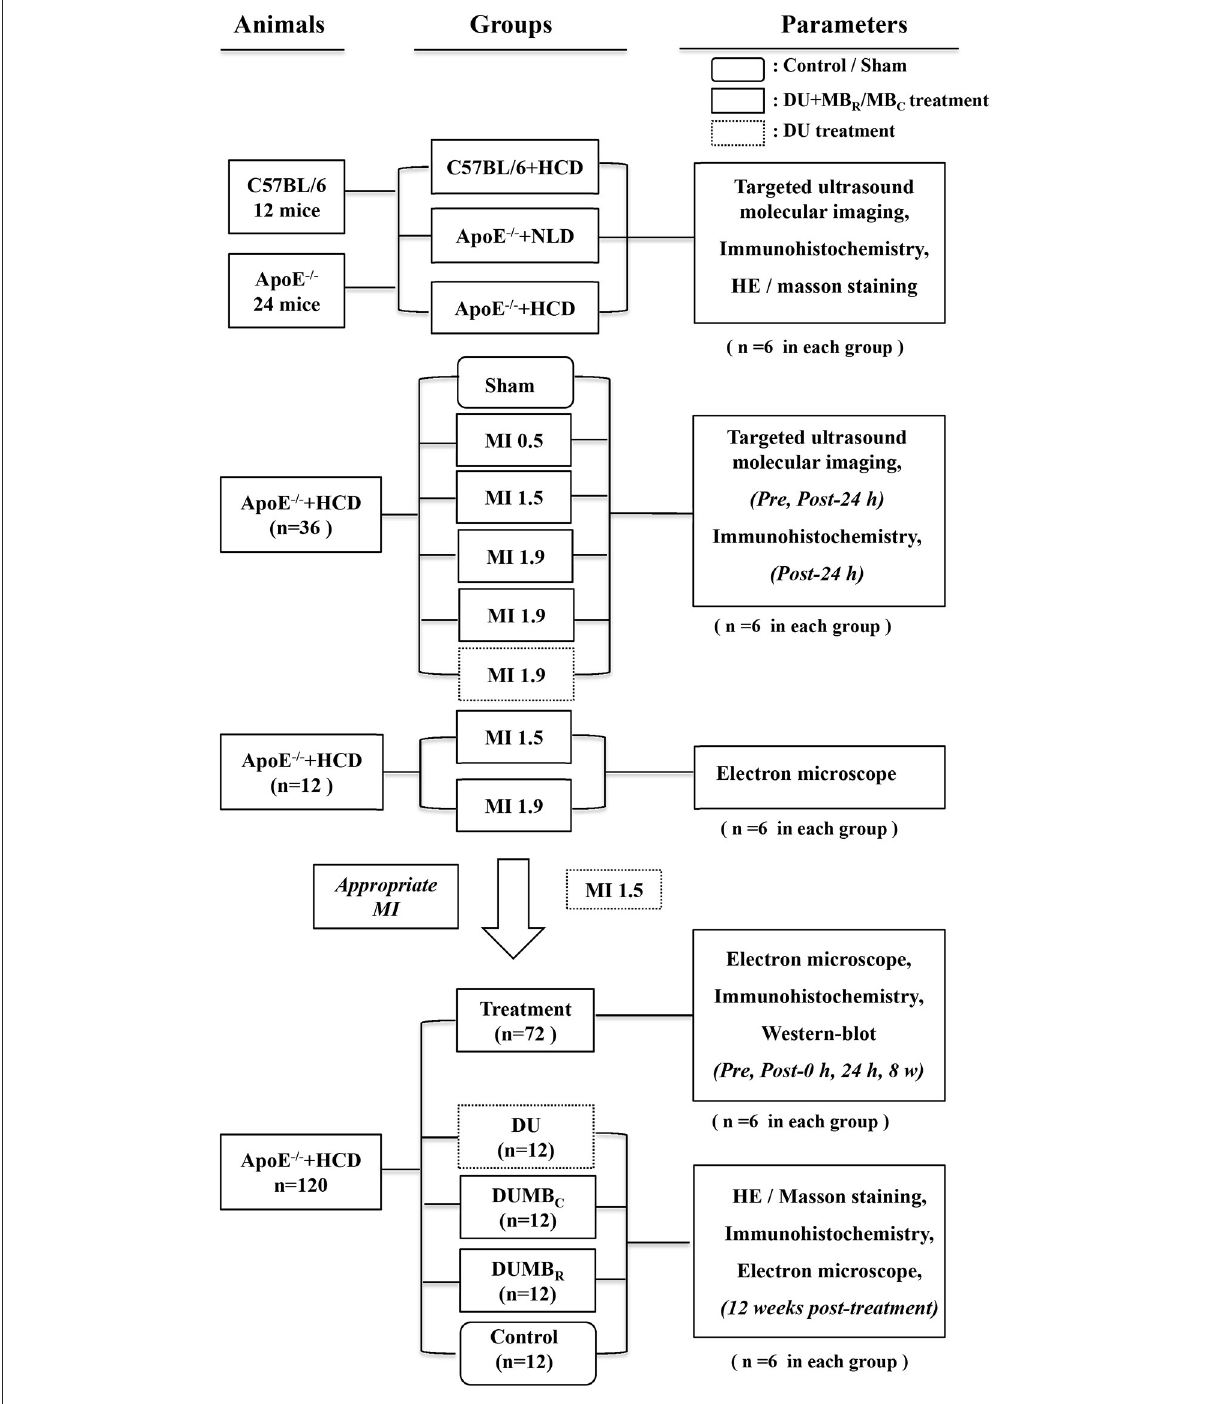
FIGURE1 Illustration of the experimental protocol.